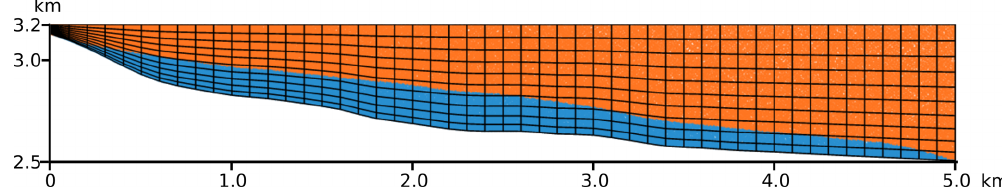
Figure 5. Grid geometry and particle distribution used for Experiment E, representing Haut Glacier d’Arolla. Particles carry the rheological properties of ice and air. Blue: ice. Red: